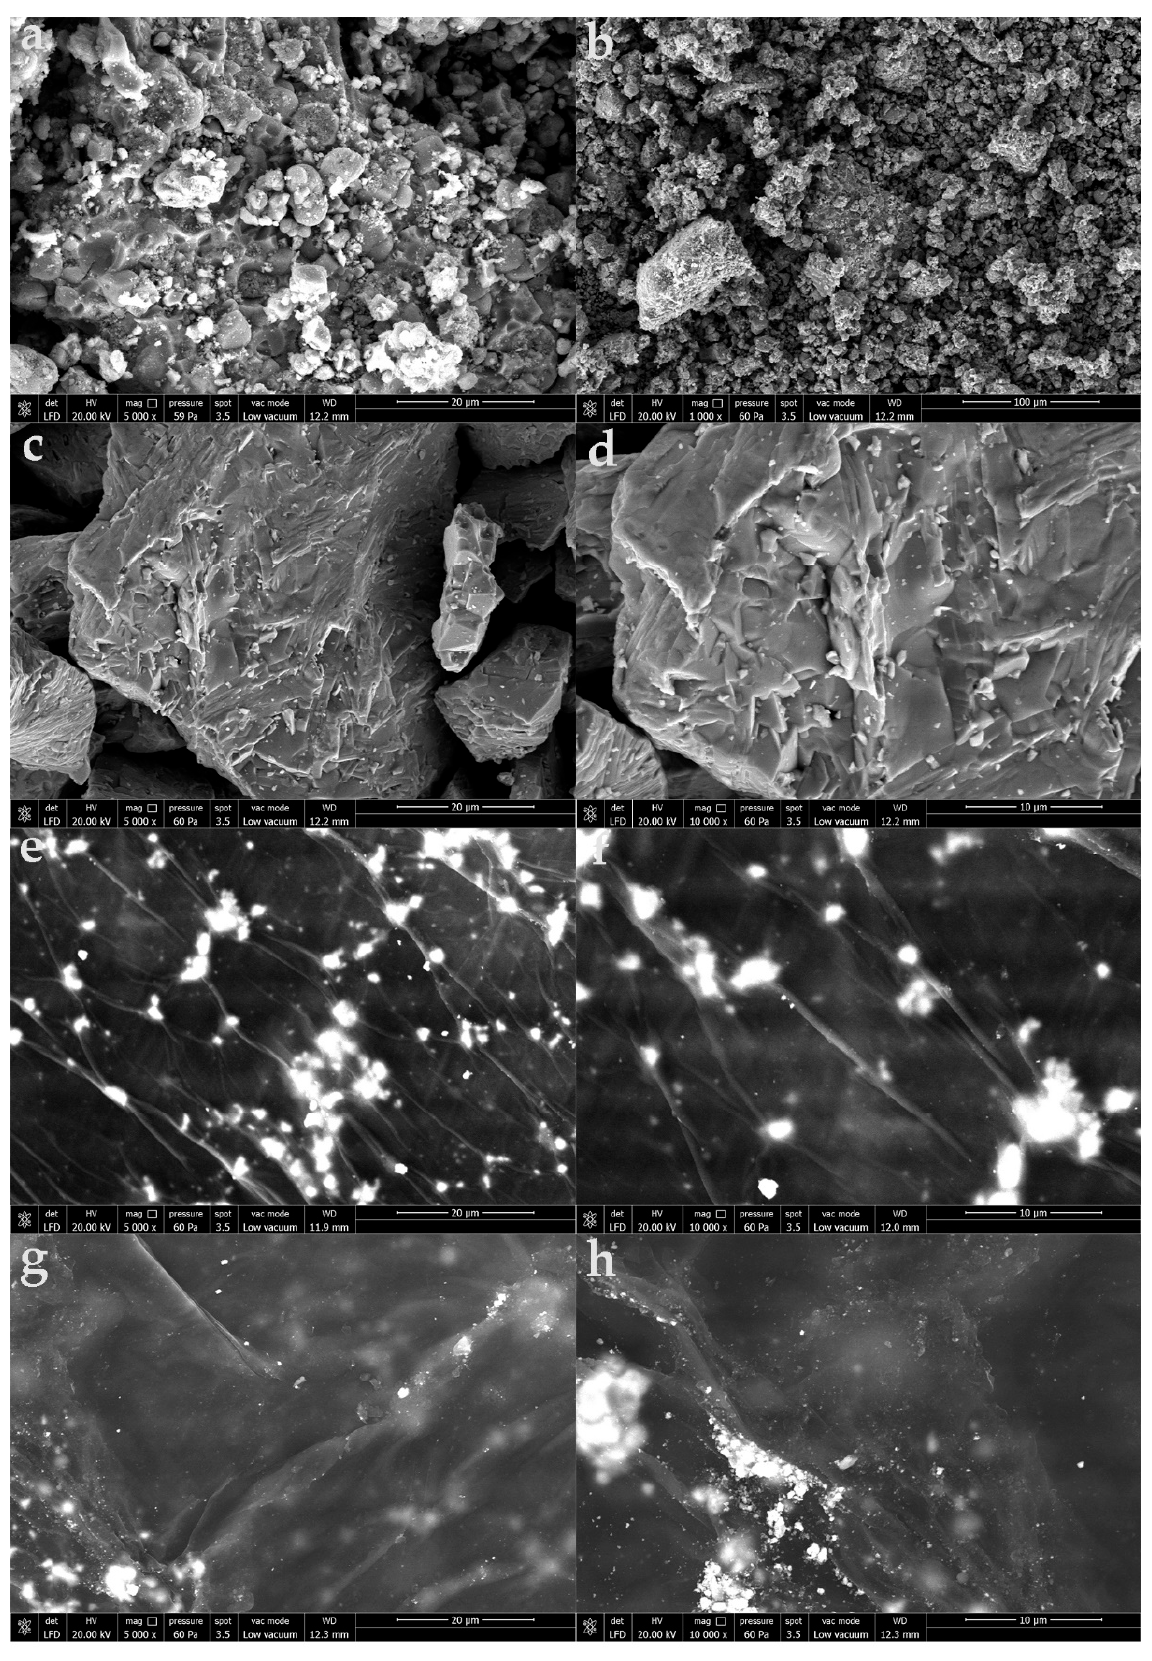
Figure 5. SEM images of WO 3 ( a , b ), WC ( c , d ), WO 3 /GO ex situ synthesis ( e , f ), and WO 3 /GO in situ synthesis ( g , h ).